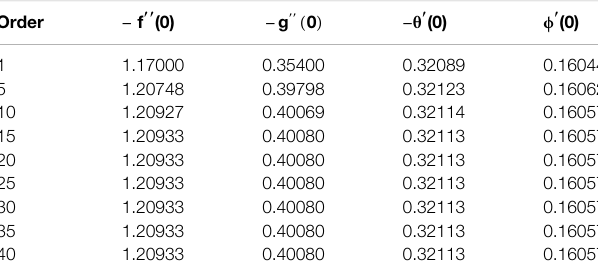
TABLE 1 | Homotopy Analysis Method order. Order